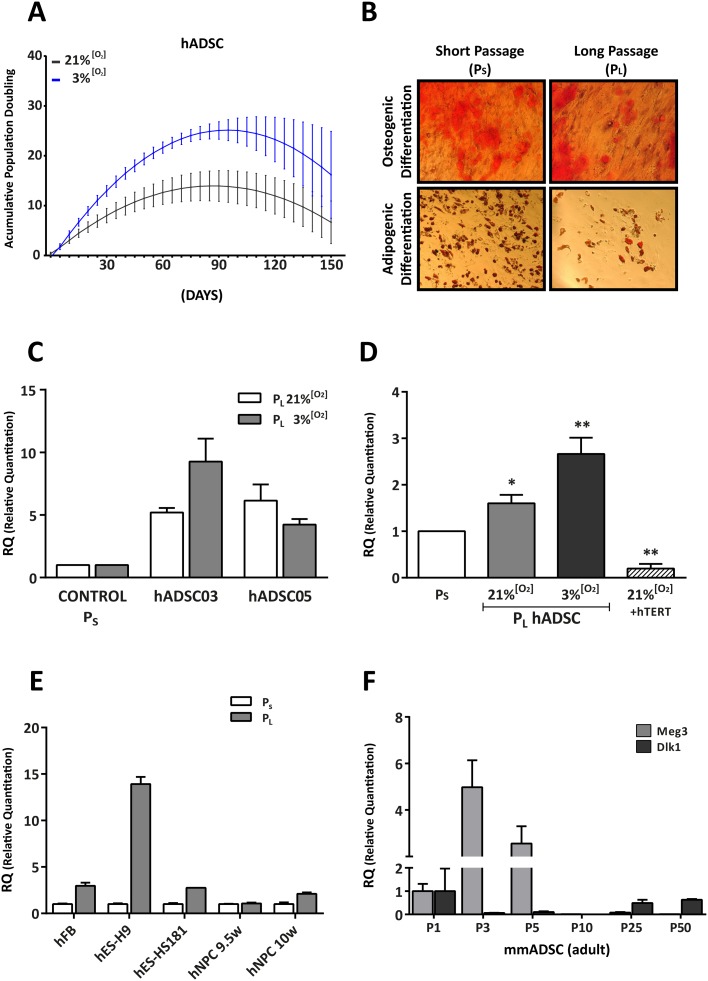
Replicative senescence is associated with upregulated lncRNA MEG3 expression.(A) Model of hADSC proliferation kinetics. From the cumulative population doubling data for different hADSC cultures, we obtained a curve fitted to a polynomic function that modeled hADSC proliferation kinetics. The various hADSC cultures were used to establish a mean proliferation curve for 150 days. Each dot represents the mean ± SEM of data obtained by modeling the different hADSC cultures. (B) Representative images indicating loss of differentiation potential (adipogenic and osteogenic) in PL cultures as compared with PS cultures of hADSCs. (C) Relative quantitation of MEG3 lncRNA in two different hADSC samples (n = 3 technical replicates) cultured for short (PS) and long (PL) periods. Data shown represent mean ± SEM. (D) Relative quantitation of MEG3 expression in PS and PL hADSC cultures from a different source, Inbiobank (aADSC, n = 4 biological replicates; with overexpressed hTERT; +hTERT, n = 2 biological replicates); data represent mean ± SEM (* p <0.05, ** p <0.01, *** p <0.001; two-tailed paired t-test). (E) Relative quantitation of MEG3 expression in different cell models (hFB, human fibroblasts; hES-H9, human embryonic stem cell H9; hES-HS181, human embryonic stem cell HS181; hNPC 9.5w, human neural precursor cells from a 9.5-week fetus; hNPC 10w, human neural precursor cells from a 10-week fetus); shown is a representative experiment with 3 technical replicates. (F) Relative quantitation of Meg3 and Dlk1 expression in mouse ADSCs (mADSCs) at various passages; shown is a representative experiment with 3 technical replicates. Data represent mean ± SEM.